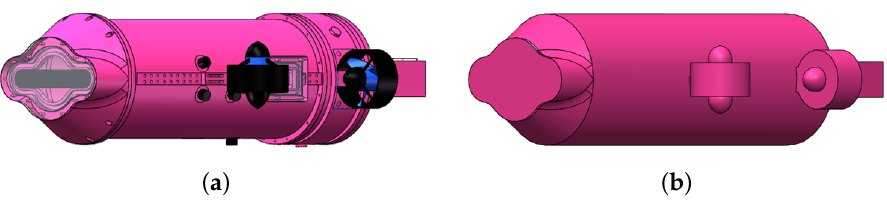
Figure 2. 3D model simplification of the underwater vehicle. ( a ) Original 3D model of the underwater vehicle; ( b ) Simplified 3D model of the underwater